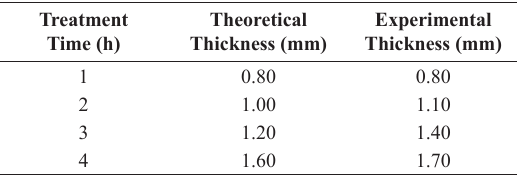
Table 5- Results obtained by different analysis techniques for the diffusion coefficient of carbon obtained by the gas carburization of AISI P20